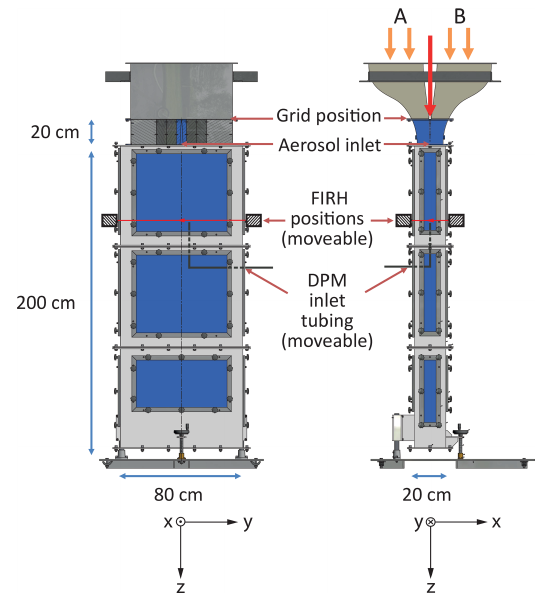
Figure 1. Schematic of the measurement section of LACIS-T. A and B mark the two air streams which are mixed in the measurement section. The red arrow marks the location where aerosol particles can be injected. Axes are included in order to display the geome- try where z = 0 is the tip of the aerosol inlet, and x = 0 and y = 0 are the centrelines of the two transverse dimensions of the measure- ment section. The red lines denote the position of the Fast Infrared Hygrometer (FIRH) optical paths. The thick grey lines denote the inlet tubing of the dew-point mirror (DPM) hygrometer. Adapted from Niedermeier et al.